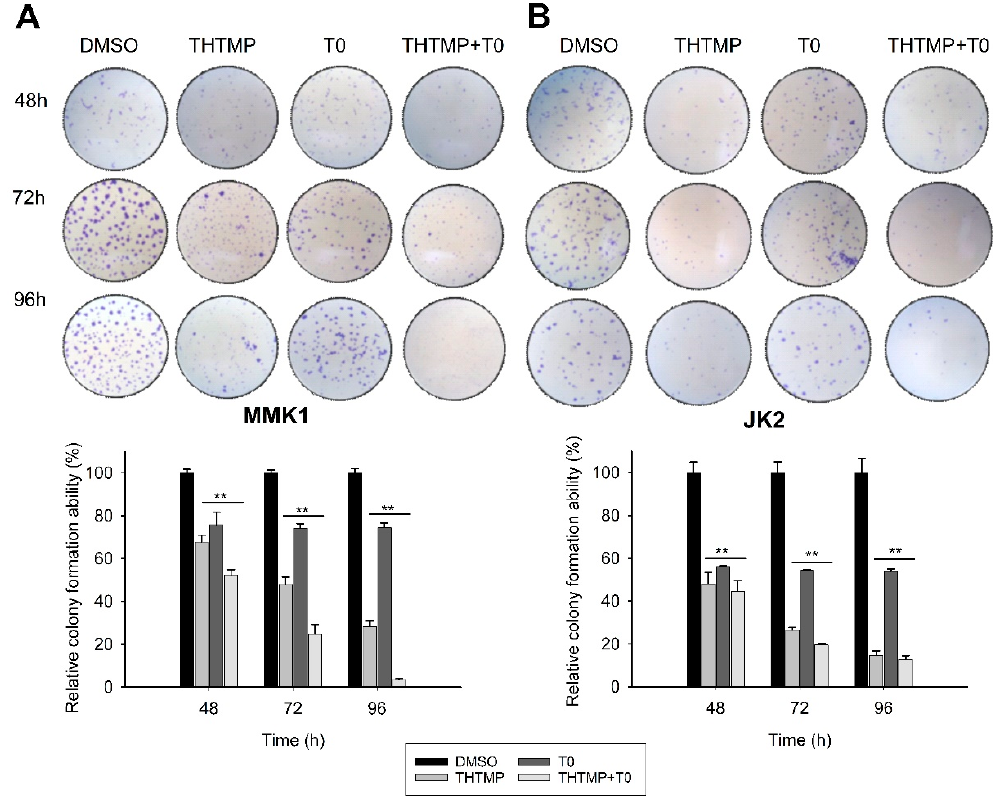
Figure 4. Effect of THTMP, T0 and combination of THTMP + T0 on colony formation ability on ( A ) MMK1 and (B ) JK2. Time-lapse microscopic images of GBM cells upon treatment at 48 h, 72 h, and 96 h. The data were shown as mean ± SD, n = 3, ** p < 0.01.